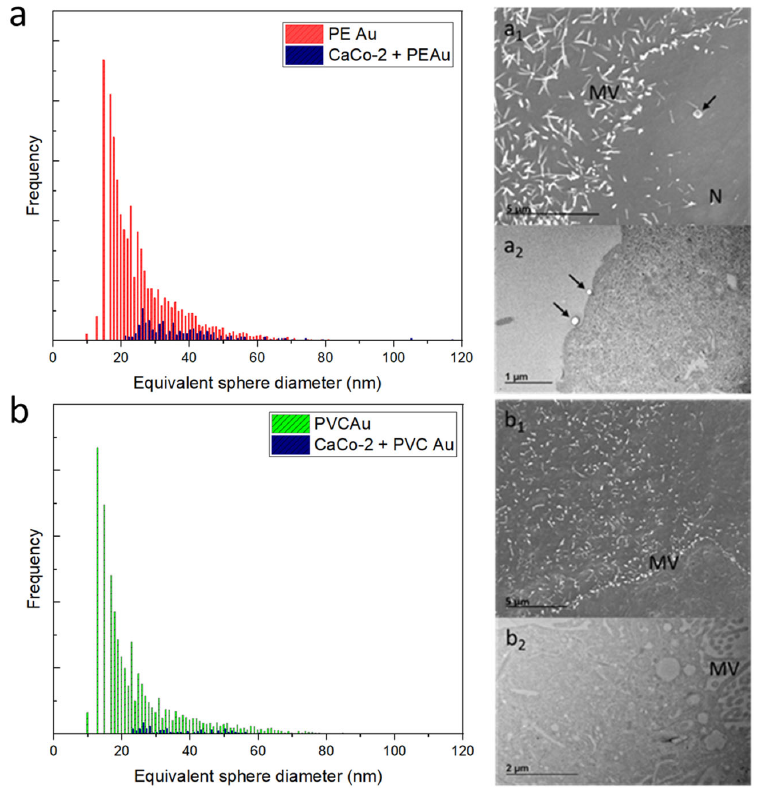
Figure 4. ( a ) Equivalent sphere diameter distribution of PE Au (red) and CaCo-2 cells incubated with PE Au for 48 h (blue) at a concentration of 1 µ g mL − 1 . ( a 1 ) The SEM image of CaCo-2 cells incubated with PE Au for 48 h does not show the presence of any nanoplastics inside the cells, yet some nanoplastics (arrow) are clearly interacting with the cell membrane andmicrovilli (MV); nucleus (N). ( a 2 ) TEM image of slices of CaCo-2 cells after 48 h of incubation with PE Au, displaying the presence of PE Au (arrows) interacting with the cellular membrane, confirming the results of the SEM analysis. ( b ) Equivalent sphere diameter distribution of PVC Au (green) and CaCo-2 cells incubated with PVC Au for 48 h (blue) at the concentration of 1 µ g mL − 1 . SEM ( b 1 ) and TEM ( b 2 ) analysis of the sample did not reveal the presence of nanoplastics, either internalized within the cells or externally interacting with the cell membrane or as a free background material.